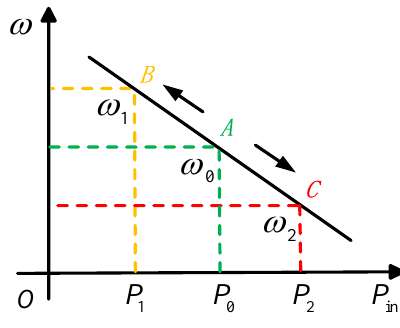
Figure 4. The frequency droop curve.